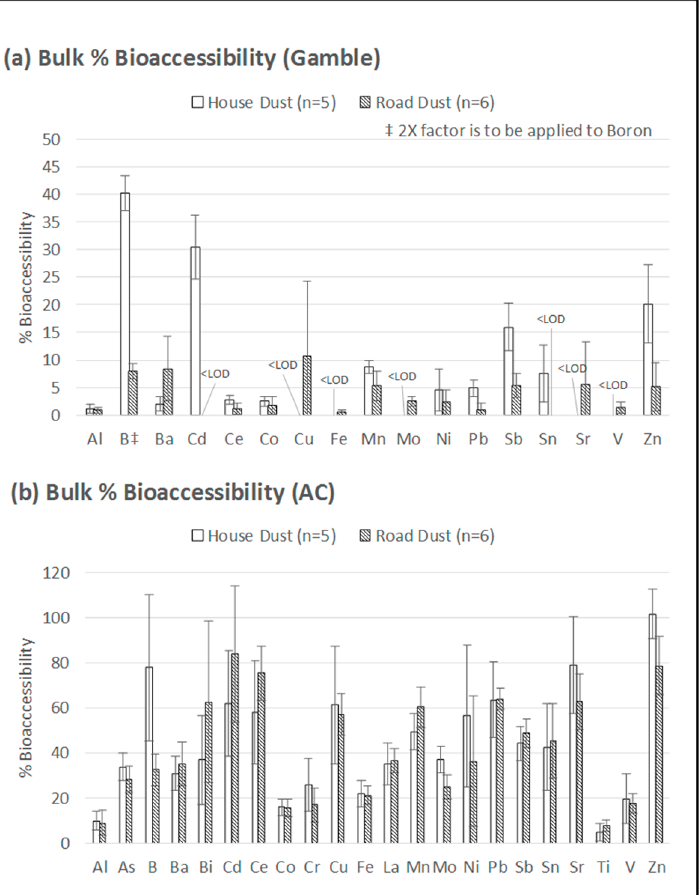
Figure 5. Bioaccessibility of elements in bulk house dust and bulk road dust using ( a ) Gamble extraction at pH 7.2, and ( b ) 0.1 M ammonium citrate (AC) extraction at pH 4.4. ‡ Boron concentration was halved in 5a to fit the graph. Error bars = standard deviations.